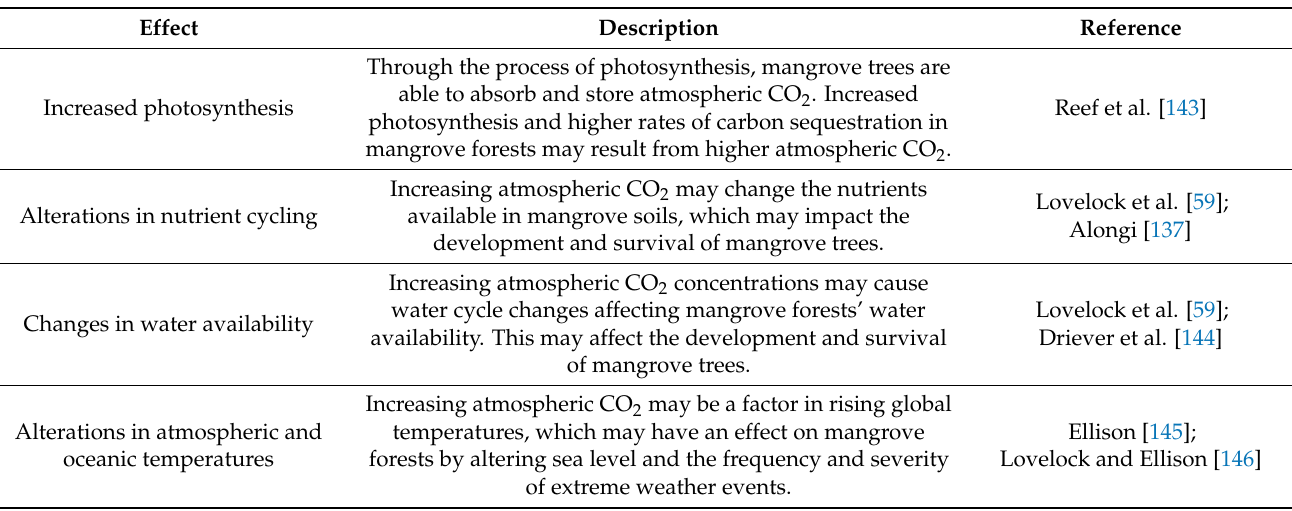
Table 12. Increased atmospheric CO 2 variability on mangrove